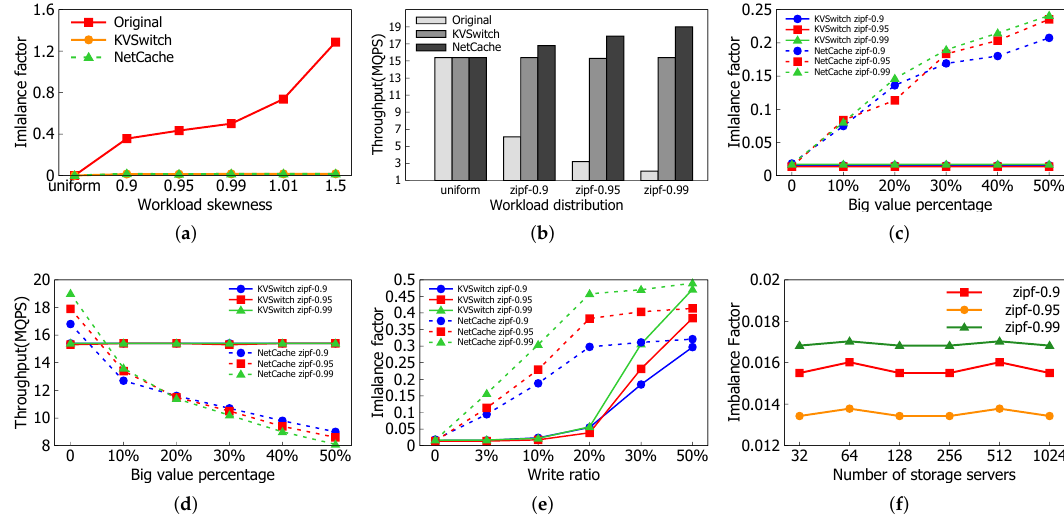
Figure 7. KVSwitch performance of load balance. ( a ) Effect of balancing techniques; ( b ) Throughput vs. skewness; ( c ) Imbalance factor vs. value size; ( d ) Throughput vs. value size; ( e ) Impact of write ratio; ( f )